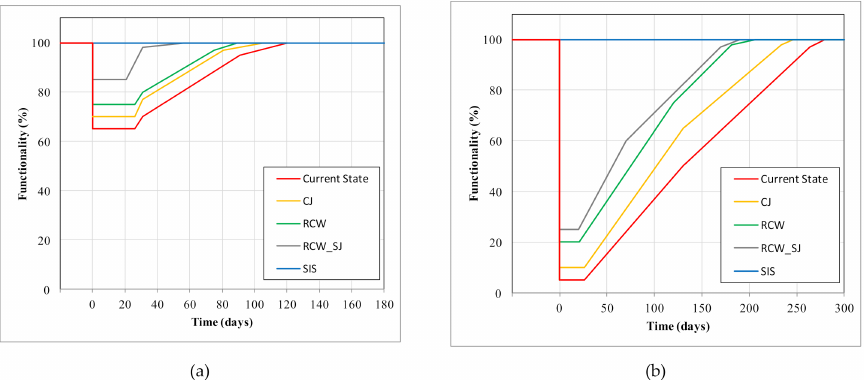
Figure 10. Resilience curves of the building under study, in its current state and with retrofitting techniques for PL1 ( a ) and PL4 ( b